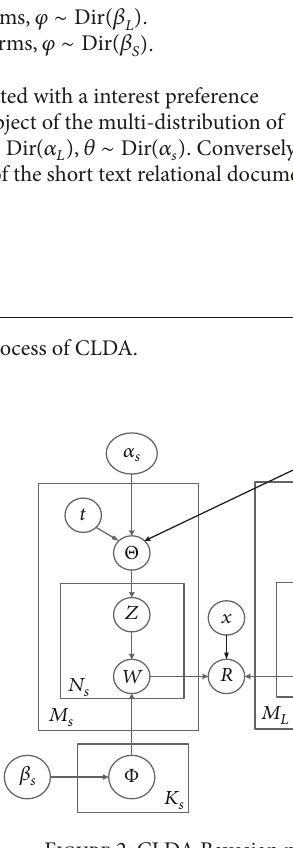
Figure 2: CLDA Bayesian network